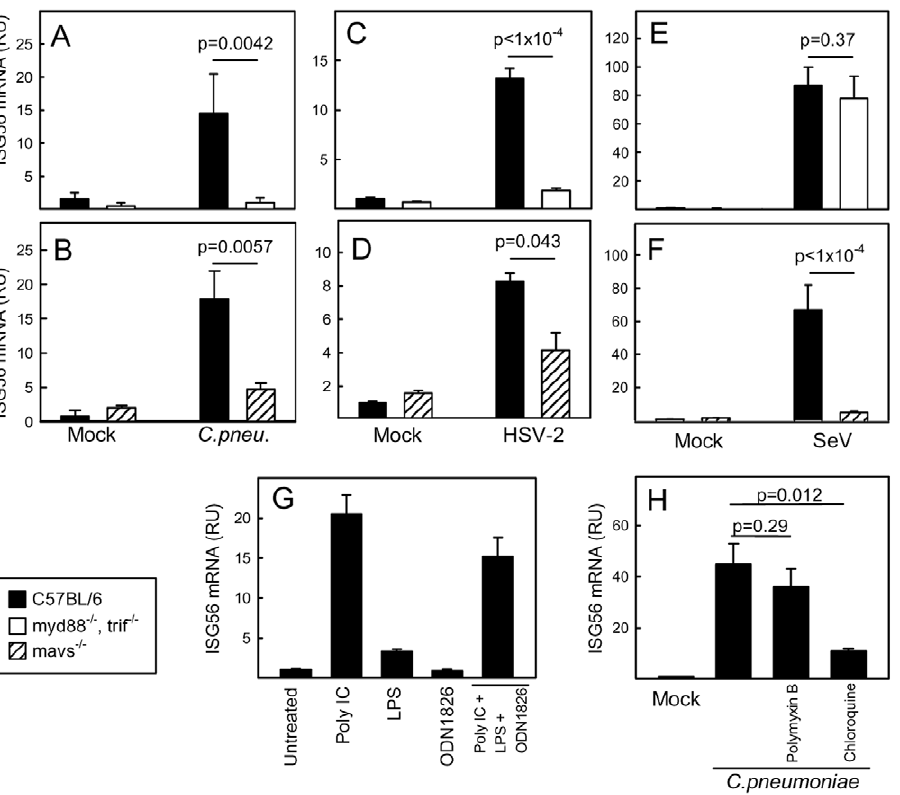
Figure 2. Chlamydiapneumoniae -induced expression of ISGs is dependent on bacterial recognition by endosomal and cytoplasmic nucleotide-sensing PRRs. (A–F) WT, myd88 2 / 2 trif 2 / 2 and mavs 2 / 2 MEFs were infected with (A–B) C. pneumoniae , MOI 5, for 36 h (C–D) HSV-2, MOI 1, 6 hrs, or (E–F) SeV, MOI 1, 6 hrs. Total RNA was harvested and levels of ISG56 mRNA were determined by real-time PCR. (G) MEFs were stimulated with polyIC (25 m g/ml), LPS (200 ng/ml), and ODN1826 (1 m M) alone or in combination as indicated. Total RNA was harvested 6 hrs post- stimulation, and levels of ISG56 mRNA were determined by real-time PCR. (H) The cells were infected with C. pneumonia , MOI 5, for 18 h in the presence or absence of polymyxin B (50 m g/ml) or chloroquine (10 m M) before harvest of total mRNA. The measured ISG56 mRNA levels were normalized to b -actin, and data are presented as means of triplicate cultures + / 2 st.dev. Similar results were obtained in 2–3 independent experiments. RU, relative units.